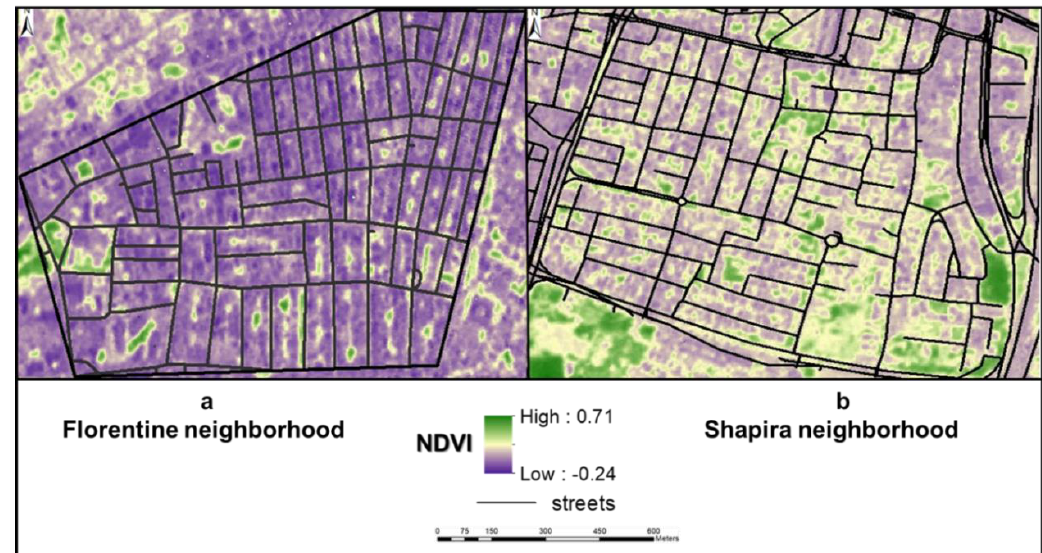
Figure 8. NDVI analysis of the neighborhoods based on Planet Scope images from 19 June 2019: ( a ) Florentine neighborhood and ( b ) Shapira neighborhood.